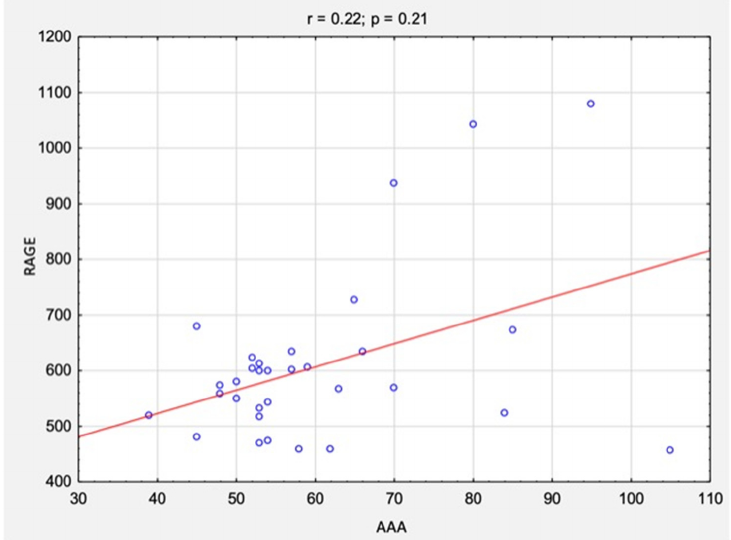
Figure 7. The correlations between the results of RAGE levels and AAA size before surgical treat- ment. Abbreviations: r, Spearman’s correlation coefficient; n, number of participants; p, level of sta- tistical significance; RAGE, receptor for advanced glycation end products; AAA, abdominal aortic aneurysm.